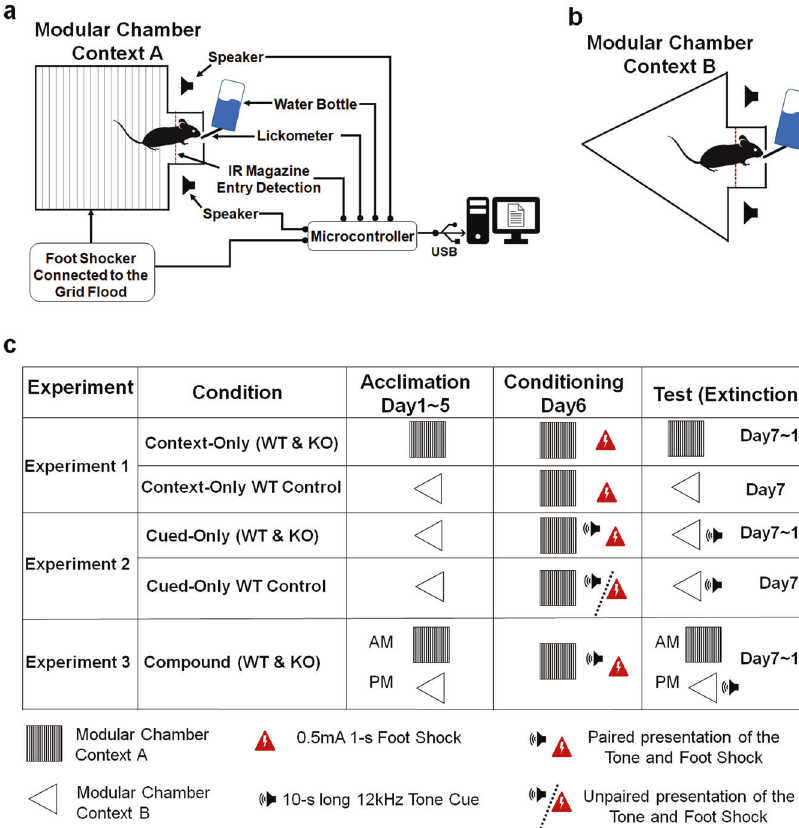
Fig. 1 Schematic representation of the experimental setup and procedures. a Schematic drawing of a mouse drinking water inside the magazine of a modular chamber (Context B). The foot shock output was connected to the grid fl oor. The foot shock input, two speakers, the infrared (IR) magazine entry sensor, and the lickometer were connected to a microcontroller. The microcontroller was connected to a microcomputer via USB cable. b Schematic representation of the modular chamber arranged in Context A, with a white plastic foam sheet covering the grid fl oor and a triangular-shaped transparent acrylic ceiling. c Experimental fl owchart for each condition (in Rows). Columns represents the three different phases of the procedure (Acclimation, Conditioning, and